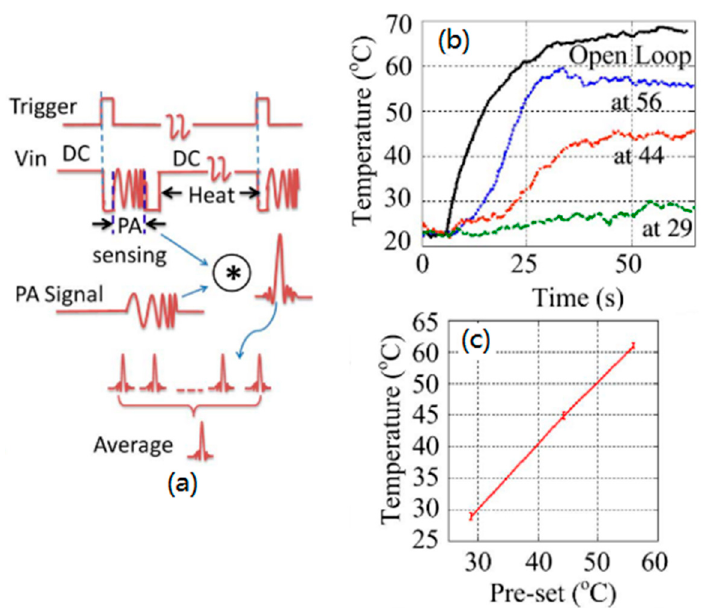
Figure 19. ( a ) Modulation scheme of the laser diode. ( b ) Self-temperature regulation with closed-loop pre-set values at 29 °C, 44 °C, and 56 °C, respectively. ( c ) Temperature-regulation accuracy analysis results. Reproduced with permission from Ref. [100].